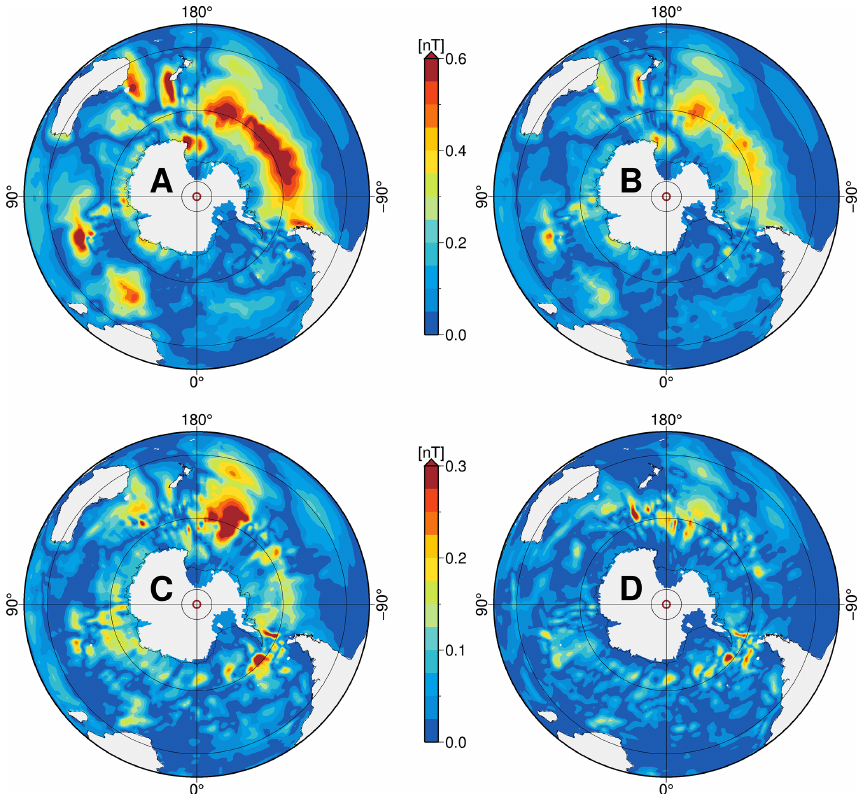
Figure 4. Absolute values of annual mean ocean-induced magnetic field residuals at sea surface in the Southern Hemisphere for scenarios A, B, C, and D with layer thicknesses of 1050, 1450, 2100, and 3000m, respectively. Note the different colour scale for scenarios C and